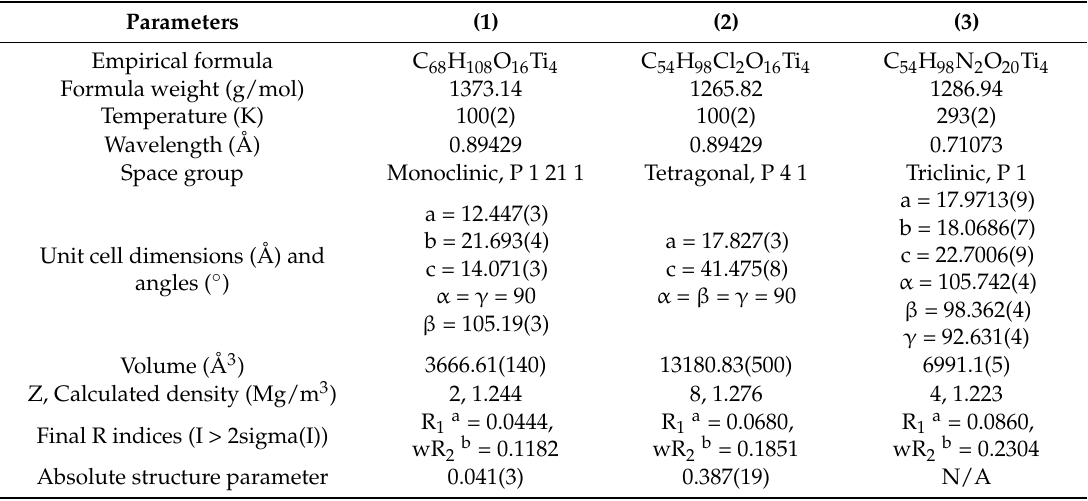
Table 1. The selected crystal data and structure refinements for (Ti 4 O 2 (O i Bu) 10 (O 2 CR’) 2 ) (R’ = C 13 H 9 ( 1 ), PhCl ( 2) , PhNO 2 ( 3 ); the complete crystallographic data are given in Table